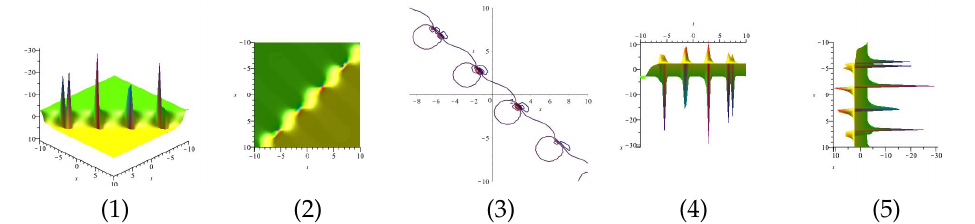
Figure 11. The 3D and 2D with the diagram of the real part of equation u 2 ( x , t ) .